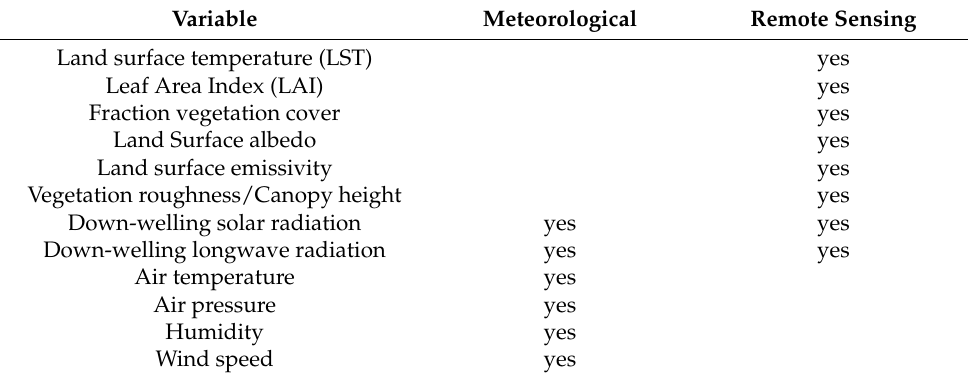
Table 1. Required inputs for the SEBS model. Variable Meteorological Remote Sensing Land surface temperature (LST) yes Leaf Area Index (LAI) yes Fraction vegetation cover yes Land Surface albedo yes Vegetation roughness/Canopy height